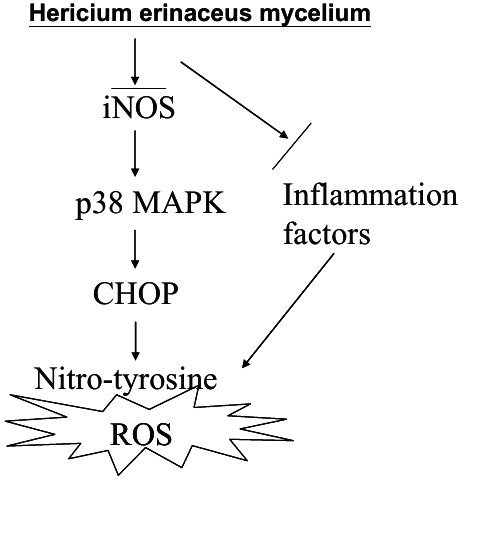
Figure 7. Schematic presentation of the signaling pathways involved in H. erinaceus mycelium inhibited transient global ischemia brain apoptosis and inflammation in